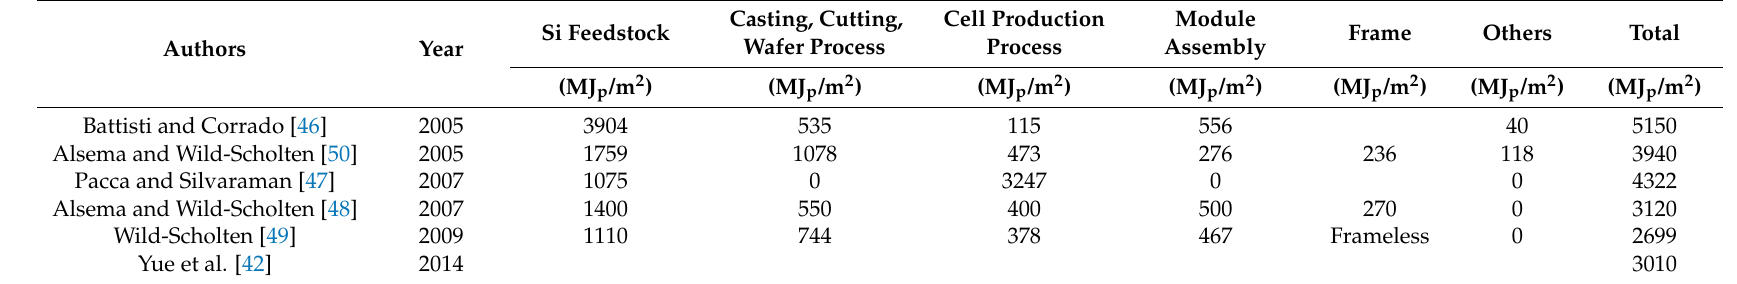
Table 1. Energy requirement for manufacturing of multi-crystalline silicon module (Multi-Si) photovoltaic (PV) plants.